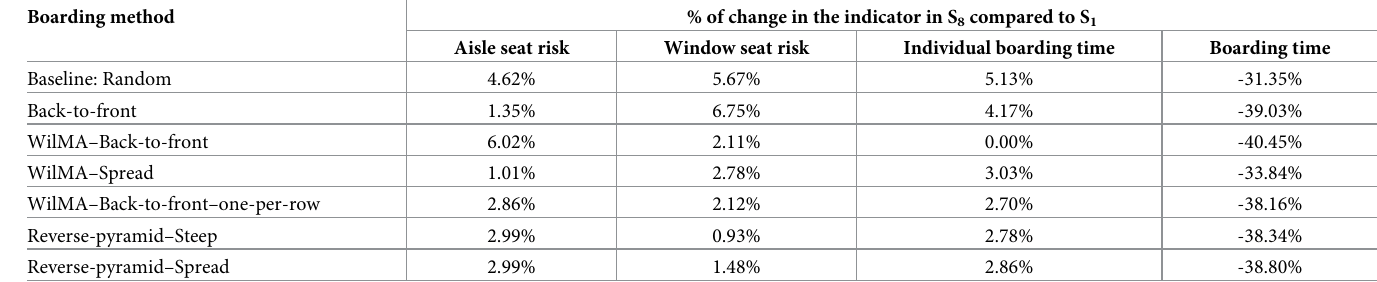
Table 10. Changes in the selected indicators in non-compliance scenario (S 8 ) compared to compliance scenario (S 1